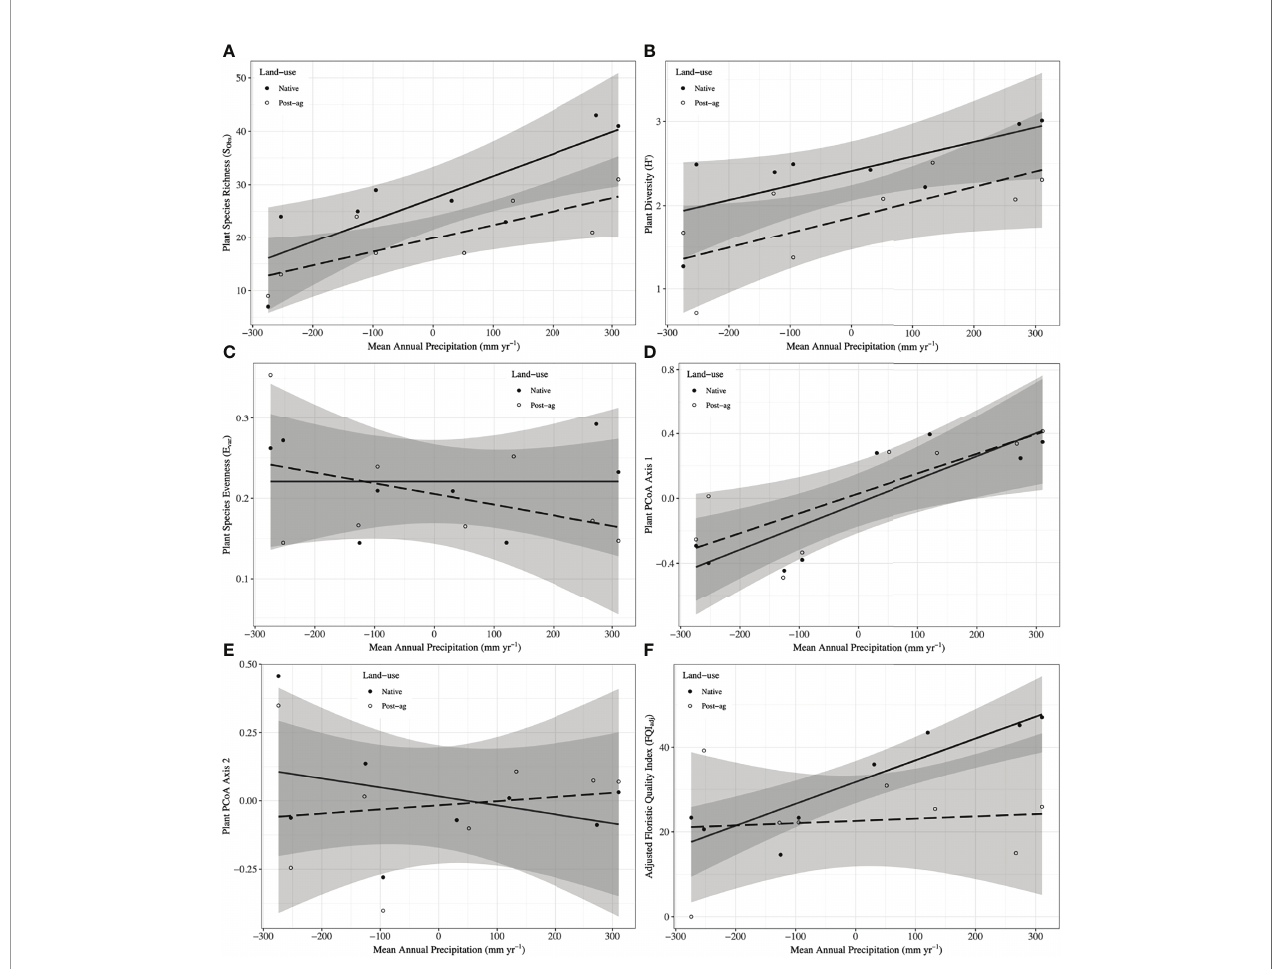
FIGURE 2 | Plant community responses to mean annual precipitation (MAP) normalized around the mean precipitation (730.01 mm yr -1 ) in native prairie remnants (solid line and fi lled symbols) and post-agricultural sites (dashed line and open symbols). Models predict observed species richness (S Obs ) (A) , Shannon diversity (H ’ ) (B) , evenness (E var ) (C) , Adjusted Floristic Quality Index (FQI adj ) (D) , PCoA Axis 1 scores (E) , PCoA Axis 2 scores (F) . The shaded areas represent 95% con fi dence intervals around the model